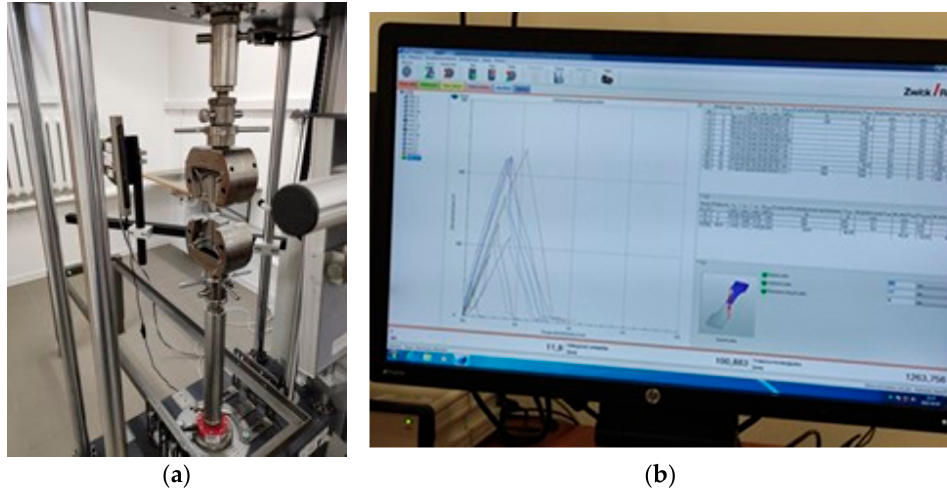
Figure 5. ( a ) KAPPA 50 DS electromechanical loading system with a ZwickRoell video extensometer and ( b ) specialized software testXpert